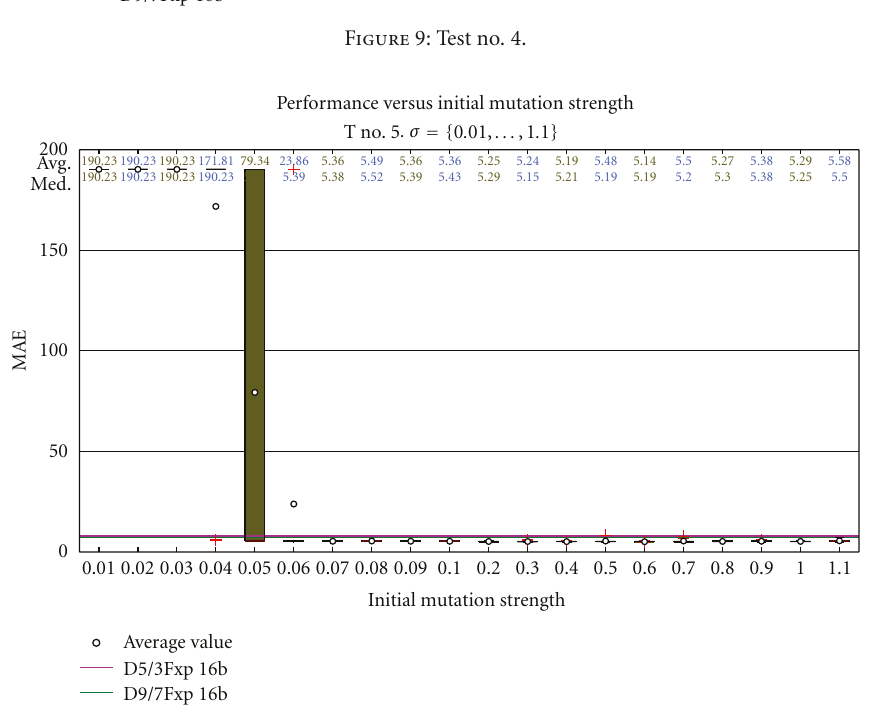
Figure 10: Test no. 5. σ = { 0 . 01, ... ,1 . 0 }